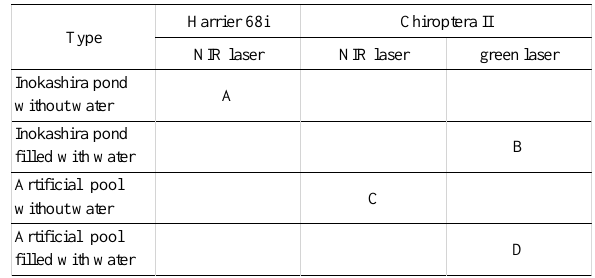
Table 2. Data collected by NIR and green laser scanning